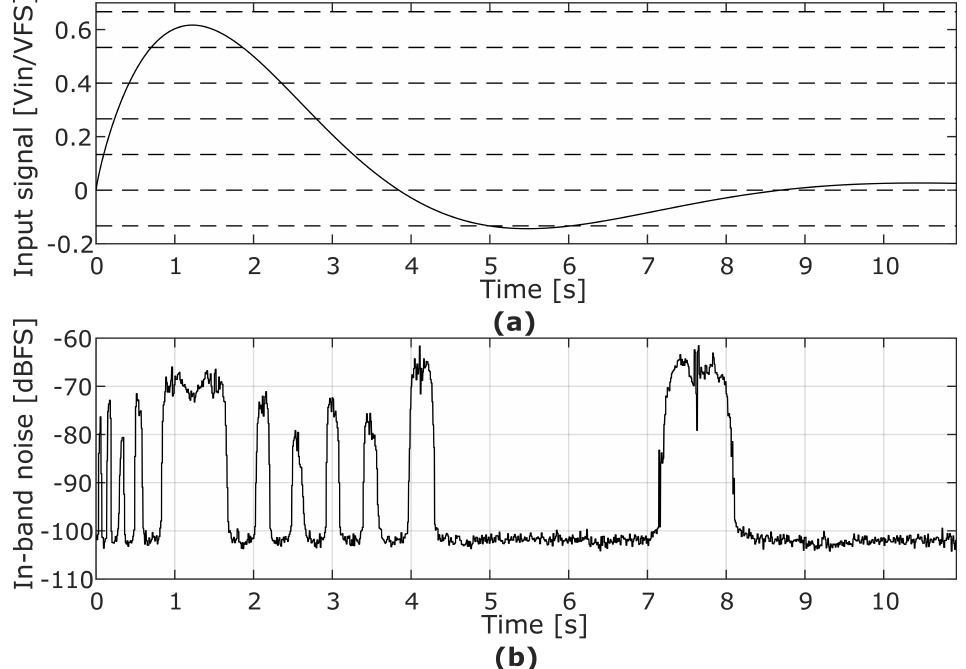
Figure 1. ( a ) Slow input signal caused by a hit (solid line) and quantizer thresholds (dashed horizontal lines). ( b ) In − band noise power.